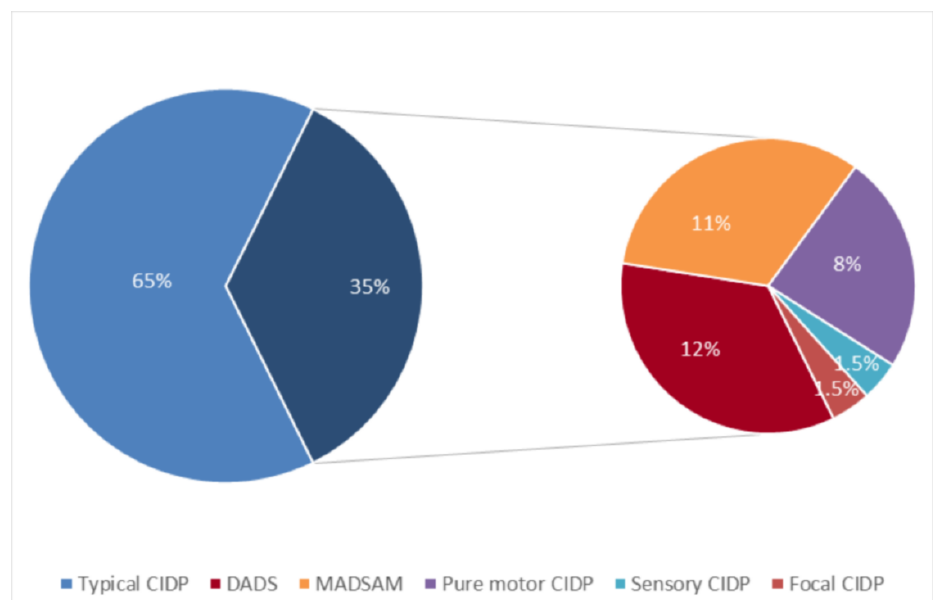
Figure 1. Distribution of clinical phenotypes in the entire chronic inflammatory demyelinating polyradiculoneuropathy (CIDP) cohort.